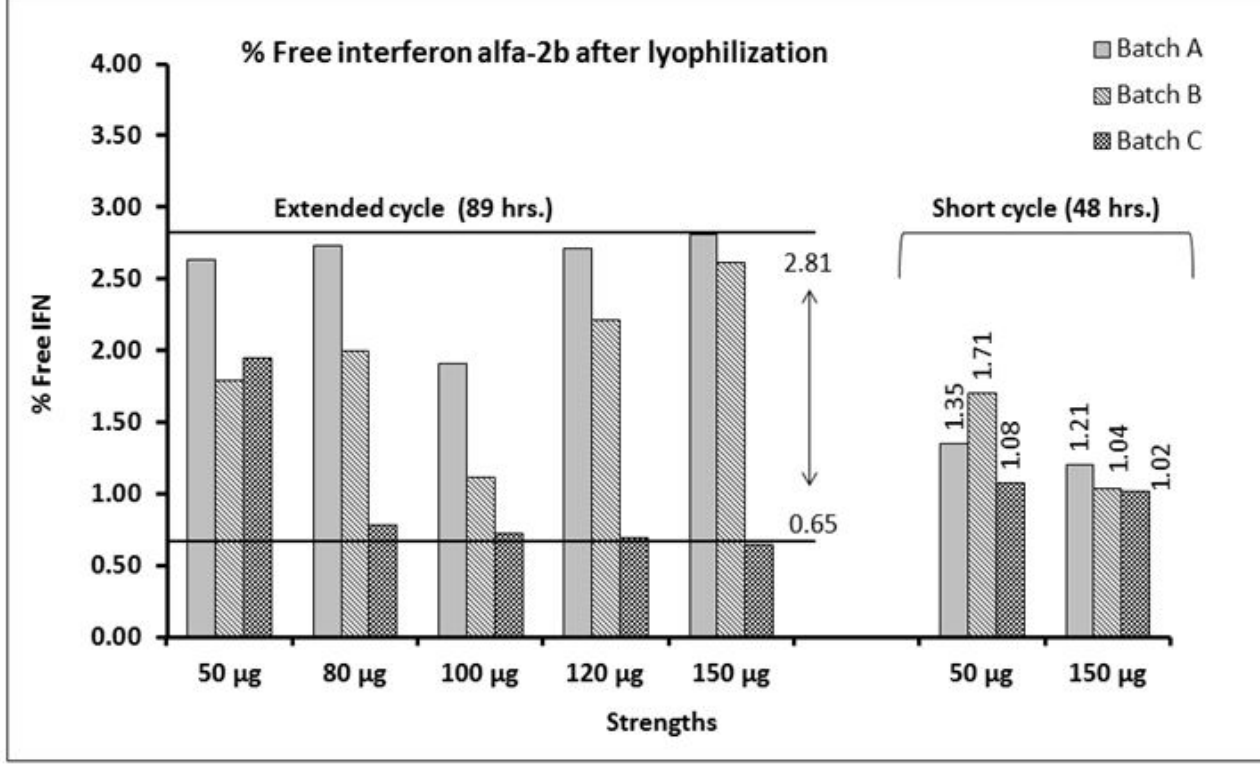
FIGURE 3 - % free interferon alfa-2b obtained with short lyophilization